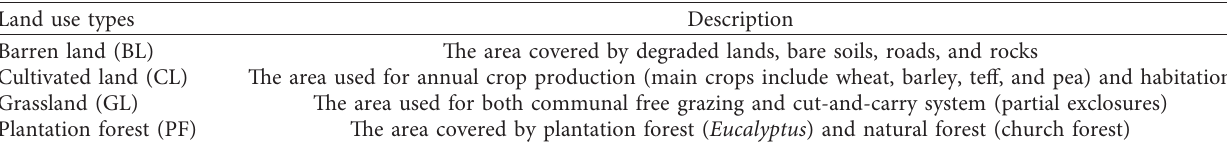
Table 1: Description of major land use